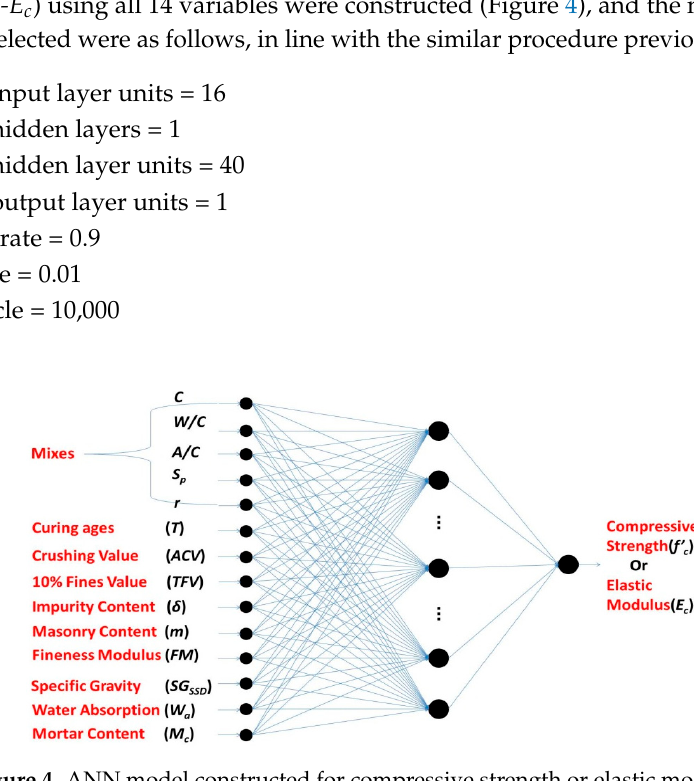
Figure 4. ANN model constructed for compressive strength or elastic modulus.